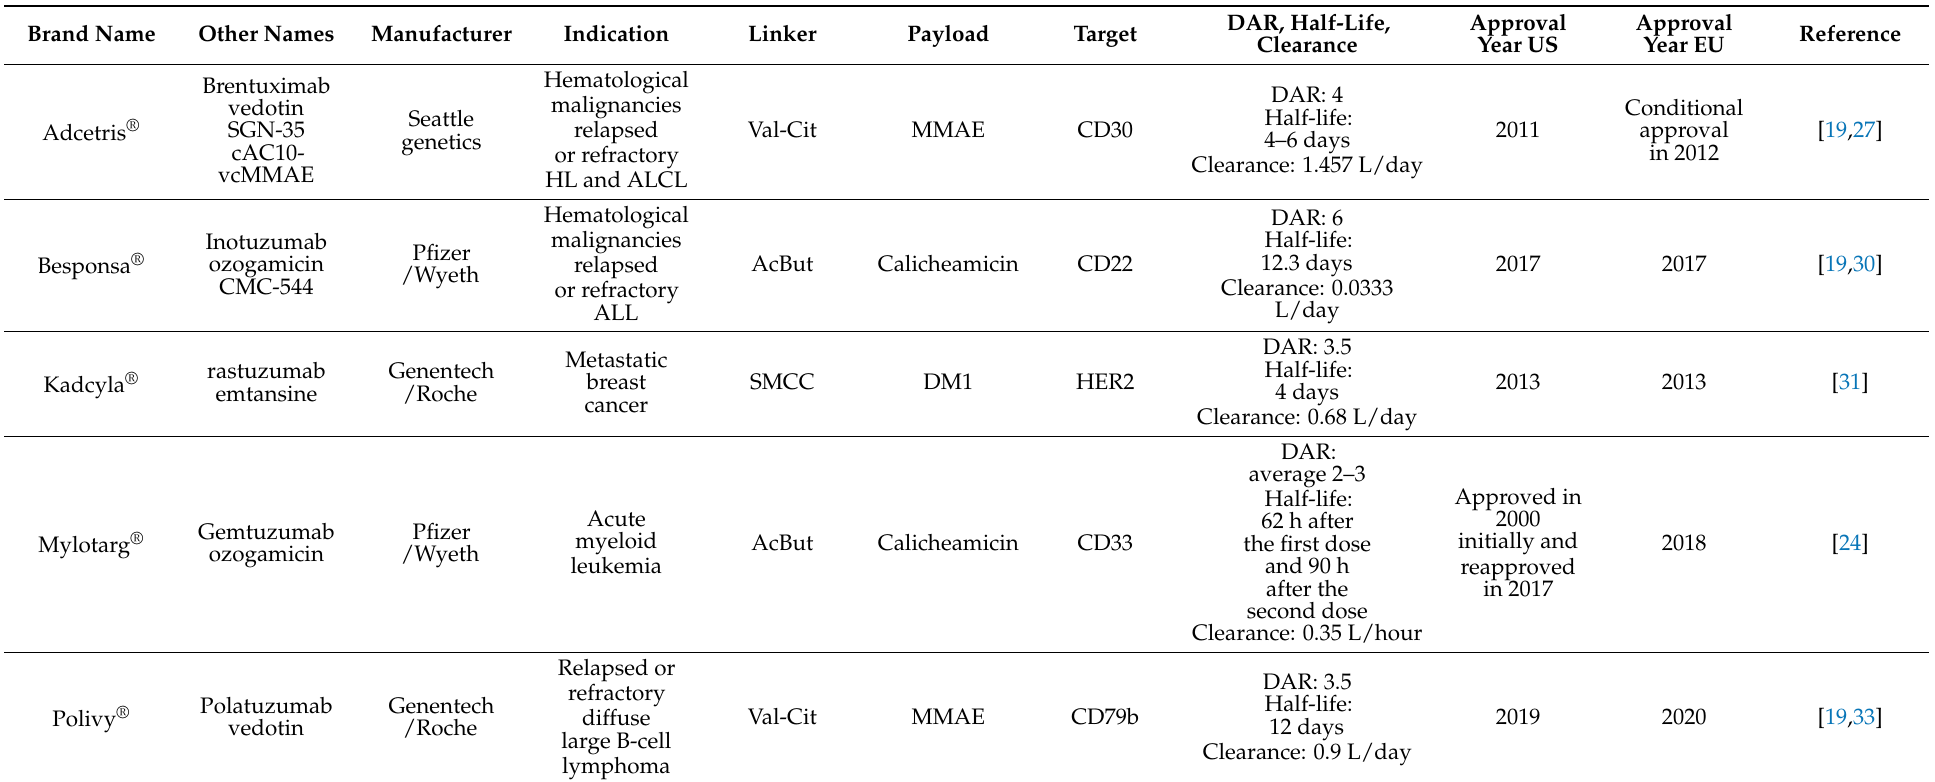
Table 1. Approved ADCs for clinical